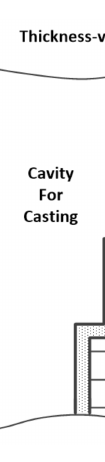
Figure 5. The typical lattice